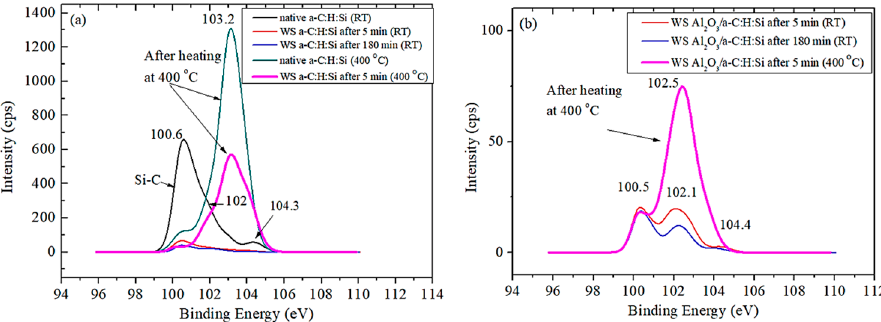
Figure 11. Si 2p XPS spectra taken within the native and wear scars surfaces after the sliding tests at RT and 400 °C on the ( a ) a-C:H:Si and ( b ) Al 2 O 3 /a-C:H:Si coatings.